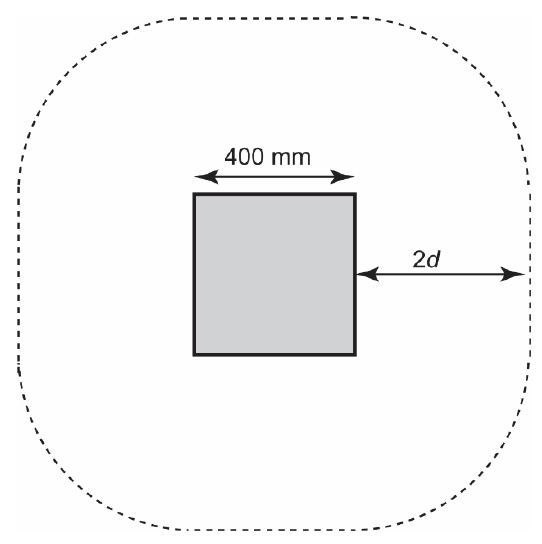
Figure 8. Punching perimeter around the wheel print.